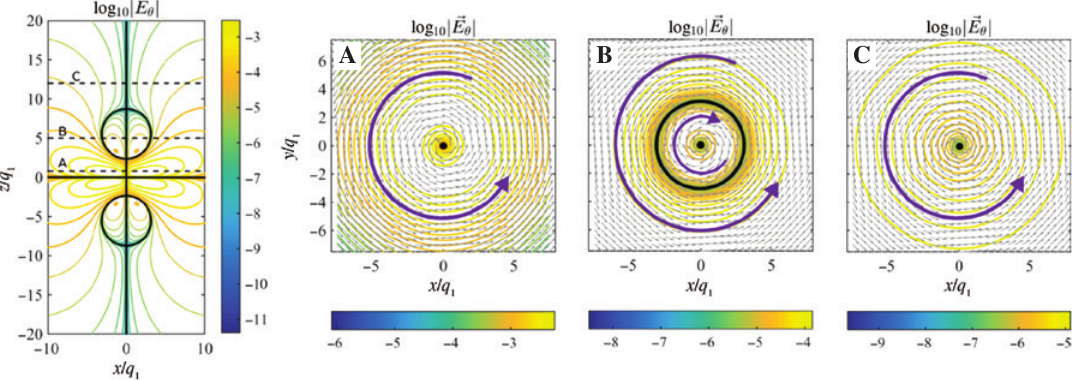
Figure 2: Electric field topology of the single-cycle TE FD pulse at focus. The left panel presents an isoline plot of the logarithm of the electric field in the xz plane. Solid black lines indicate the zeros of the electric field. Dashed lines marked as A–C indicate the z -levels of the cross-sections on the three right panels. Panels (A)–(C) present isoline plots of the logarithm of the electric field and arrow plots of the electric field direction in the xy plane. Solid black lines and black dots mark the points and areas, where the electric field vanishes. Purple arrows indicate the direction of the electric field and serve as guide to the eye. The pulse is at focus ( t = 0) and propagates along the positive z